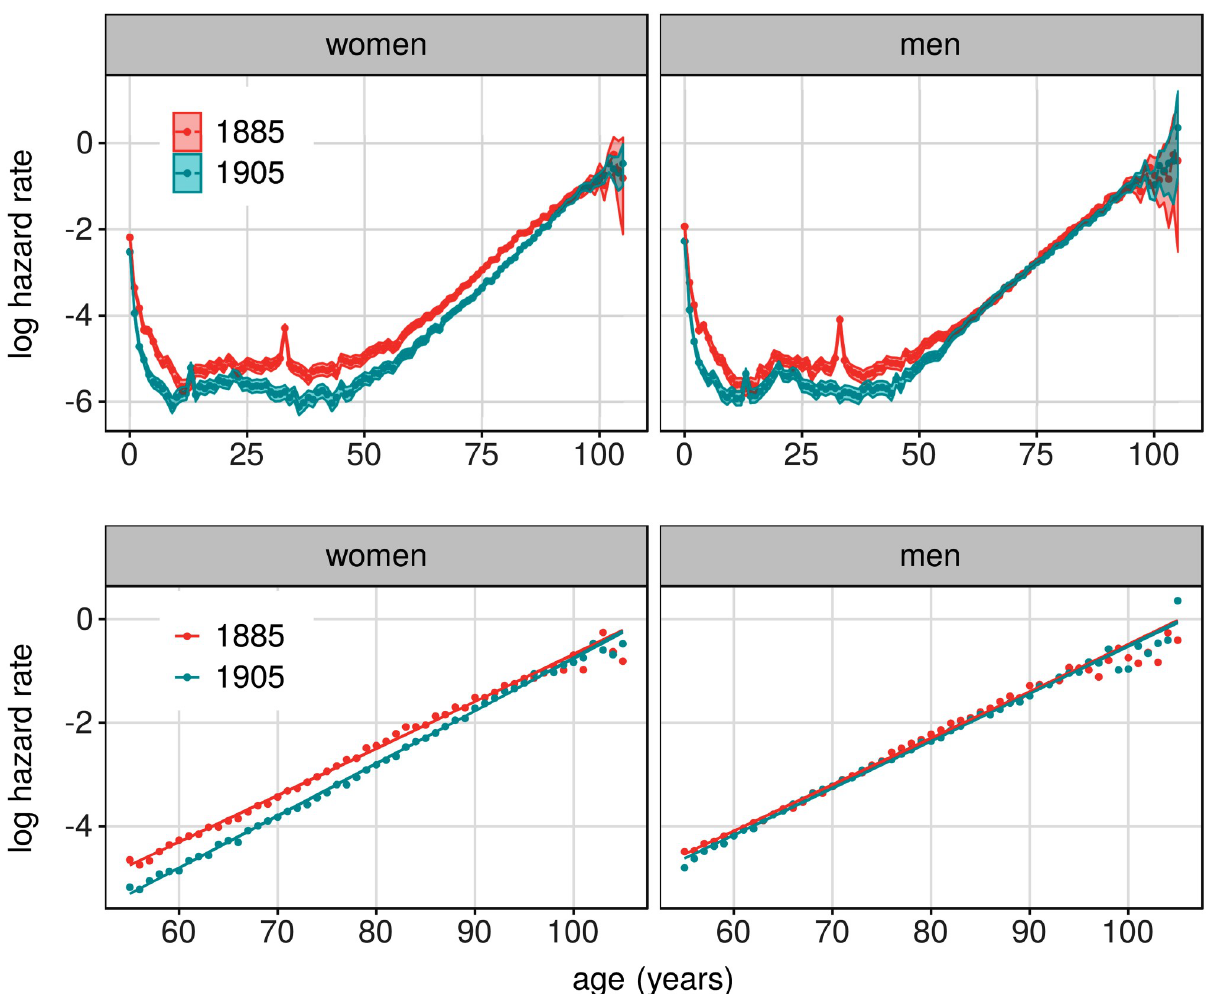
Fig 6. Hazard rates estimated from mortality data from Sweden. Top panels show estimated mortality rates for men and women born 1885 and 1905. Shaded areas show extent of 95% confidence intervals of these estimates. Lower panels show the same data, but restricted to ages � 55. Solid lines in lower panels show hazard rates from the model